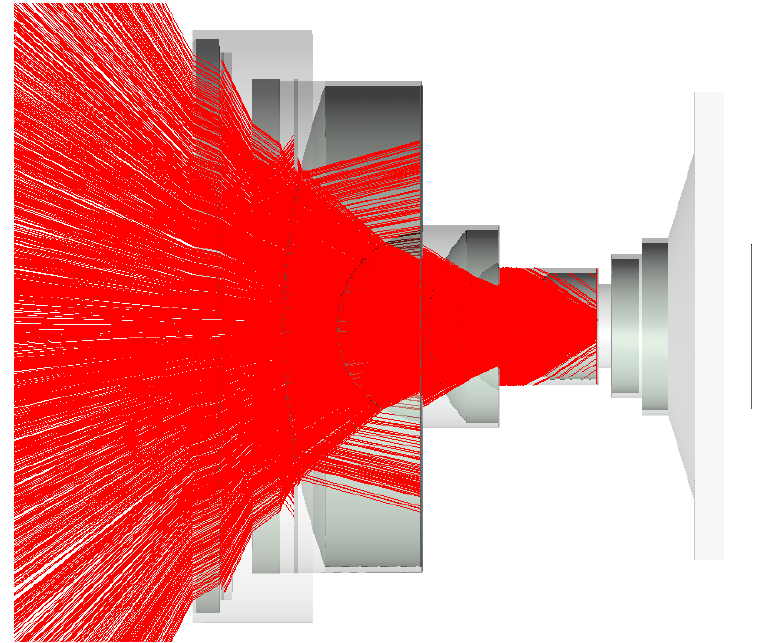
Figure 13. One million simulated rays using FRED aided in redesigning baffles and internal paint.